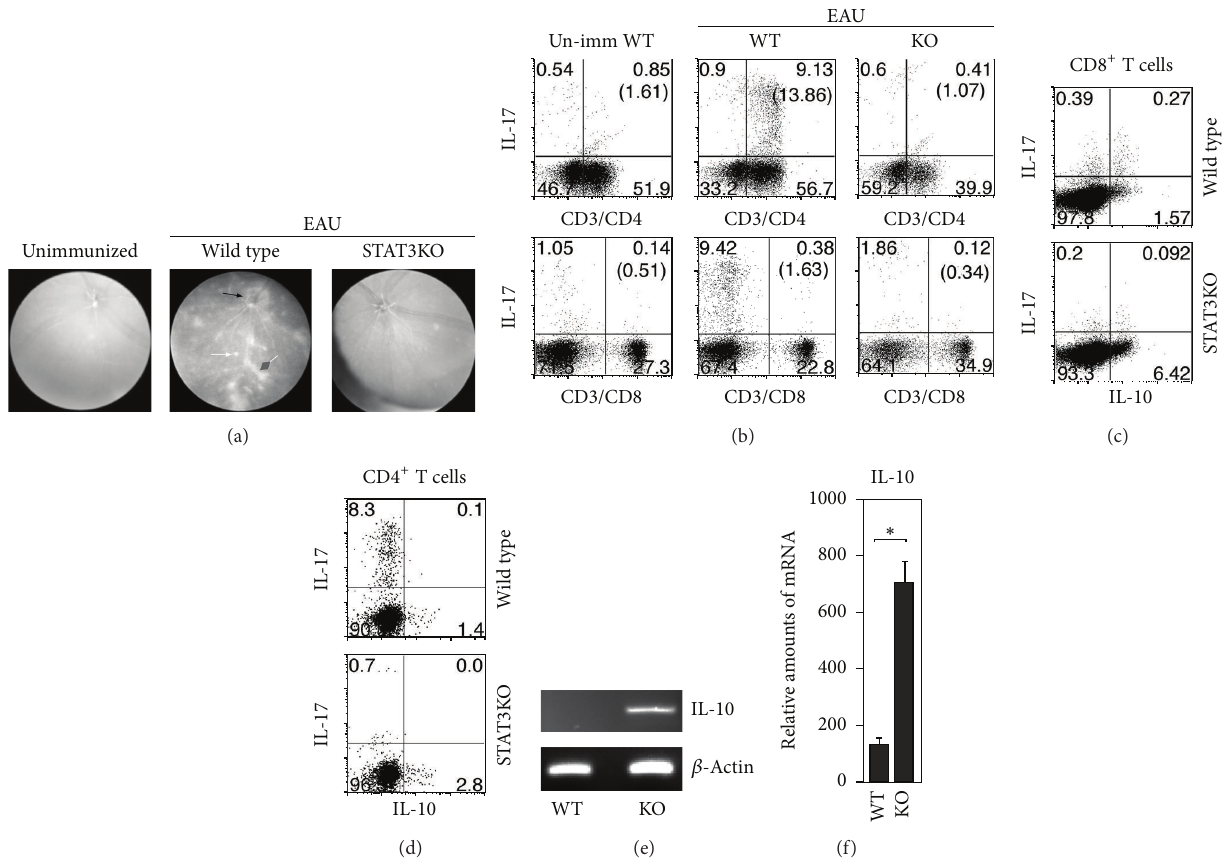
Figure 5: STAT3KO mice induce expansion of IL-10-producing regulatory CD8 + T cells during EAU. (a–d) WT or STAT3KO mice were immunized with IRBP in CFA. (a) Fundus images taken on day-21 after immunization. (b) and 21 days after immunization. Freshly isolated LN cells (21 days after immunization) were analyzed by the intracellular cytokine staining (b, c). CD3 + T cells were gated, and numbers in quadrants indicate percentage of CD4 + or CD8 + T cells expressing IL-17A or IL-10. (d, e) CD8 + T cells were isolated from the LN by magnetic sorting, and RNA was analyzed for IL-10 expression by RT-qPCR (d) or RT-qPCR (e). Data represent at least 3 independent